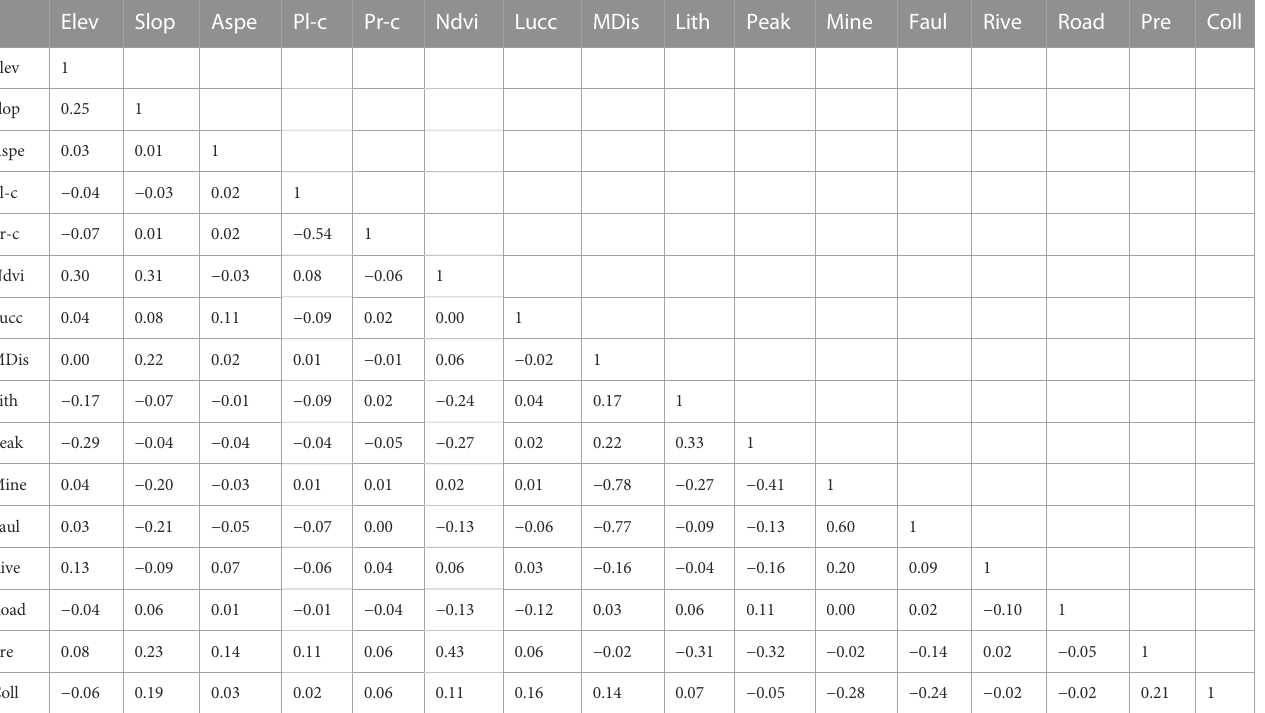
TABLE 3 Correlation between 16 condition factors.